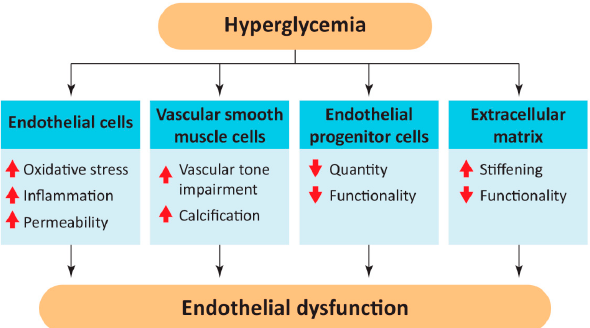
Figure 2. The cumulative effects of high glucose concentration on endothelial cells, vascular smooth muscle cells, circulating endothelial cells, and extracellular matrix that lead to endothelial dysfunction.